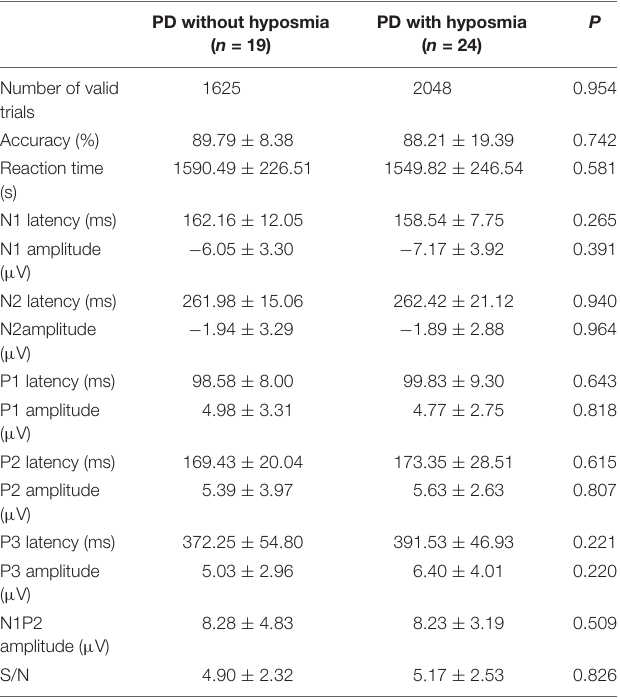
TABLE 2 | Task performance and parameters of ERP components in PD with and without hyposmia groups (mean ± standard